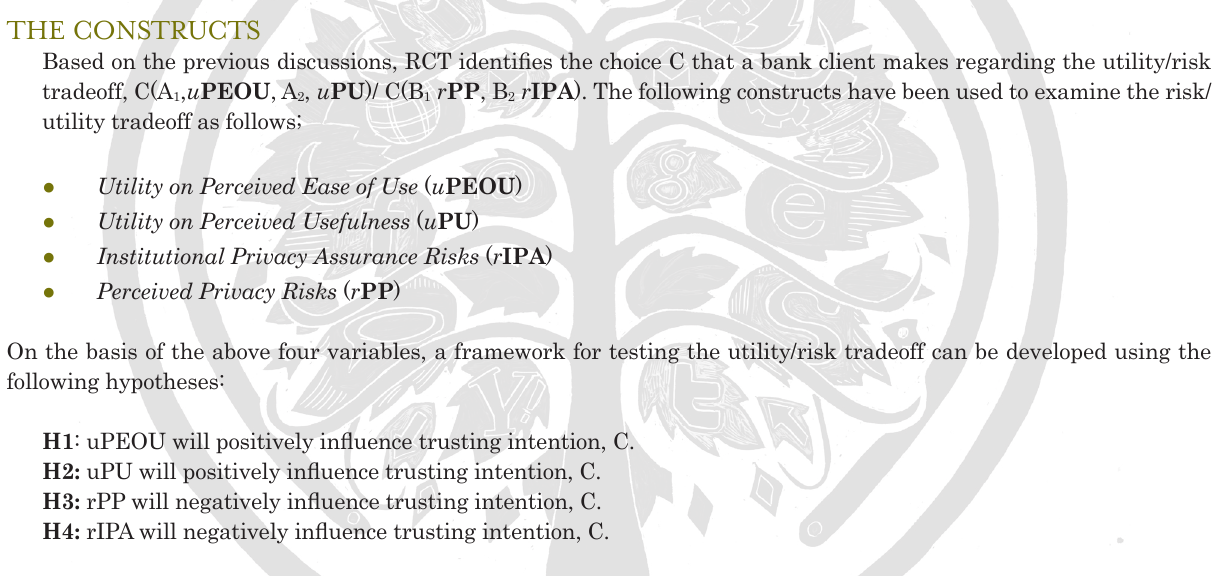
FIGURE 3: RATIONAL CHOICE CONCEPTUAL MODEL FOR UTILITY/ RISK TRADEOFF